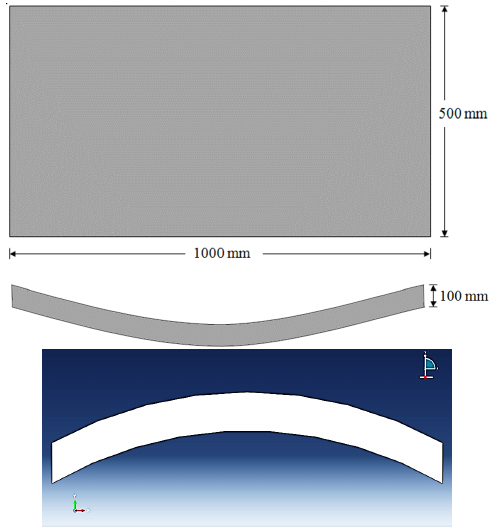
Figure 1: 2D model